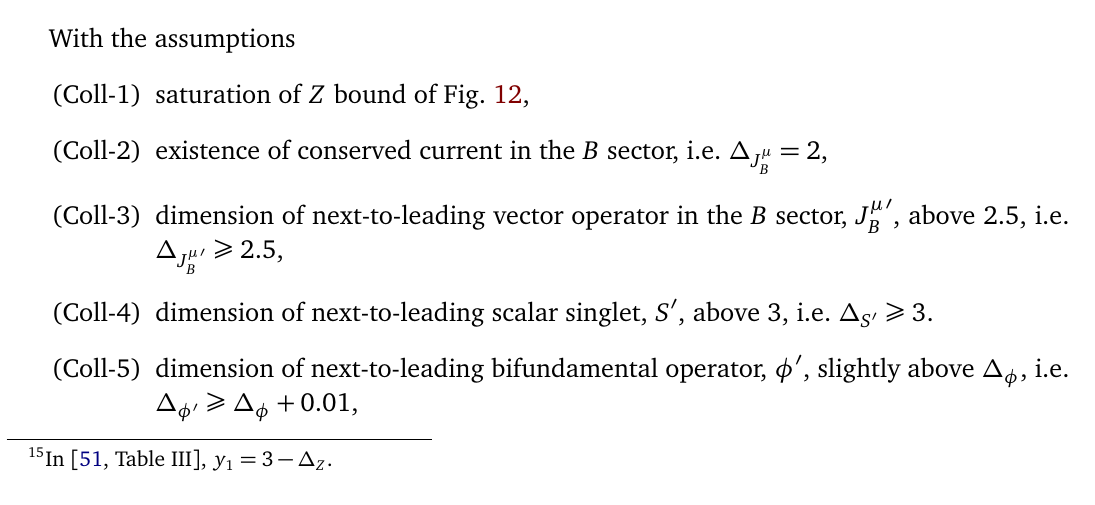
Figure 12: Upper bound on the dimension of the first scalar Z operator in the φ × φ OPE as a function of the dimension of φ . The area above the curve is ar bs